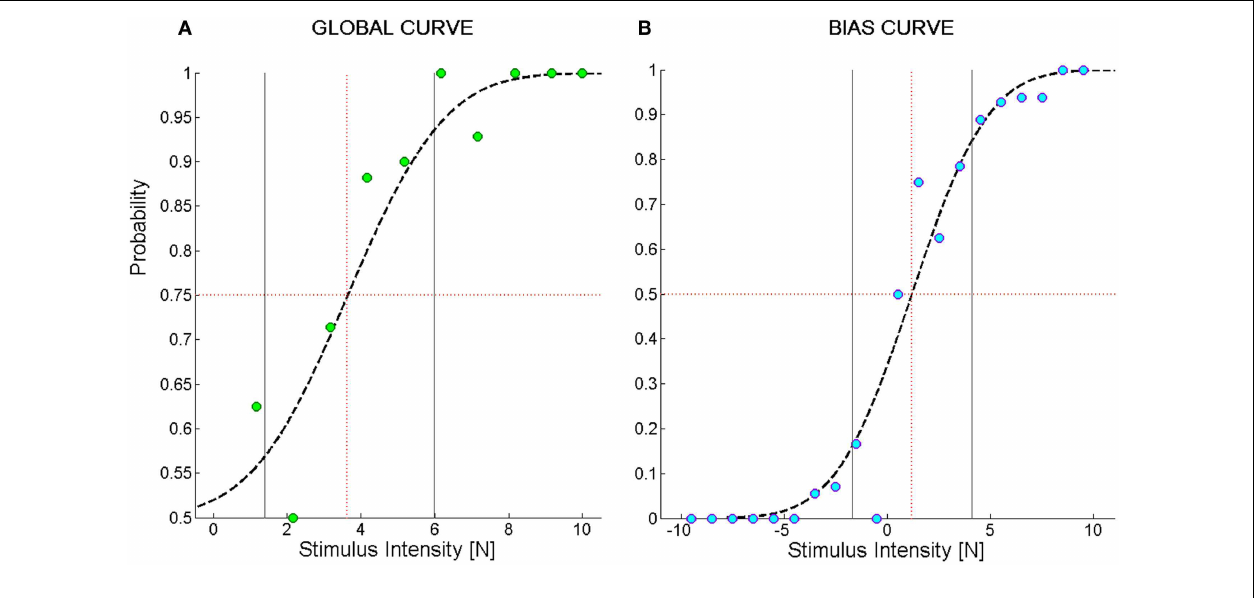
FIGURE 2 | Example of psychometric curves from the force direction discrimination task . (A) Global Curve ; (B) Bias Curve. The ordinate values indicate the probability of perceiving the direction of the force stimulus; the abscissa represents the magnitude of the force stimulus. In (B) , negative stimuli stand for forces directed to the left and positive stimuli for forces directed to the right.The green and blue filled circles represent the average probability to perceive the